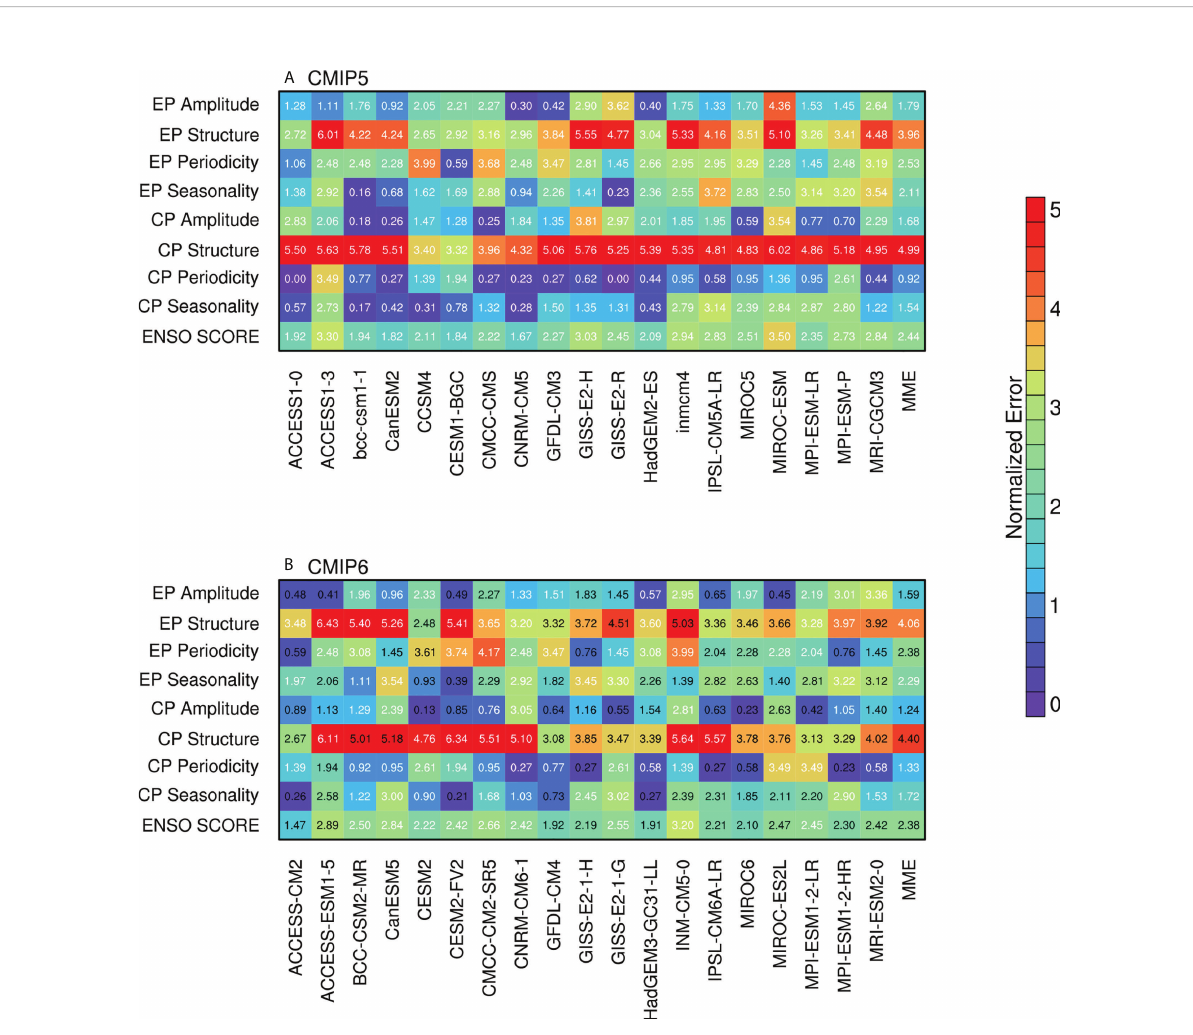
FIGURE 5 Simulation performance metrics (units: 1) for each model of (A) CMIP5 and (B) CMIP6. Eight primary metrics in terms of two types of ENSO simulation skills are used as the criteria: EP and CP ENSO amplitude (the error of the maximum standard deviation for EP and CP ENSO SSTA); EP and CP ENSO spatial structure (the spatial root mean square error of the EP and CP ENSO SSTA); EP and CP ENSO periodicity (the error of the leading periodicity of EP and CP ENSO time series); EP and CP ENSO seasonality (the error of phase-locking index for Niño3 SSTA and Niño4 SSTA). The ENSO score is de fi ned as the average of the above eight metrics. Text in each color box represents the exact score value, and the black text indicates a decreased error from CMIP5 to